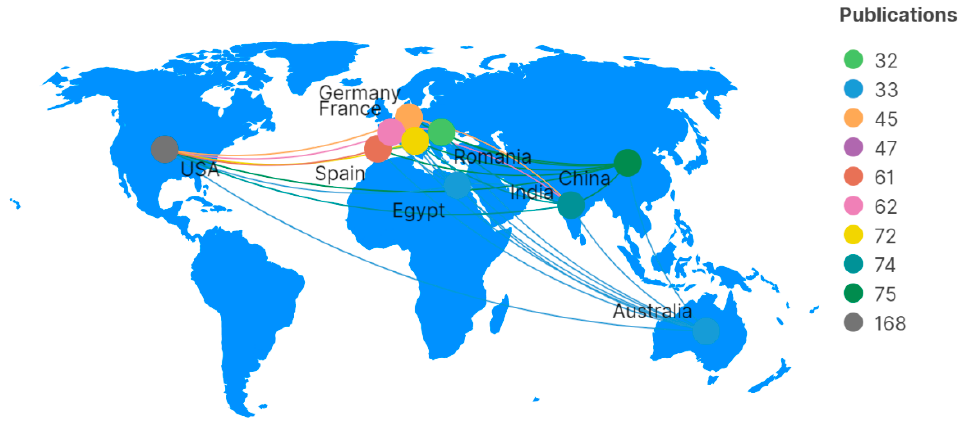
Figure 4. Publication volume by country or region.